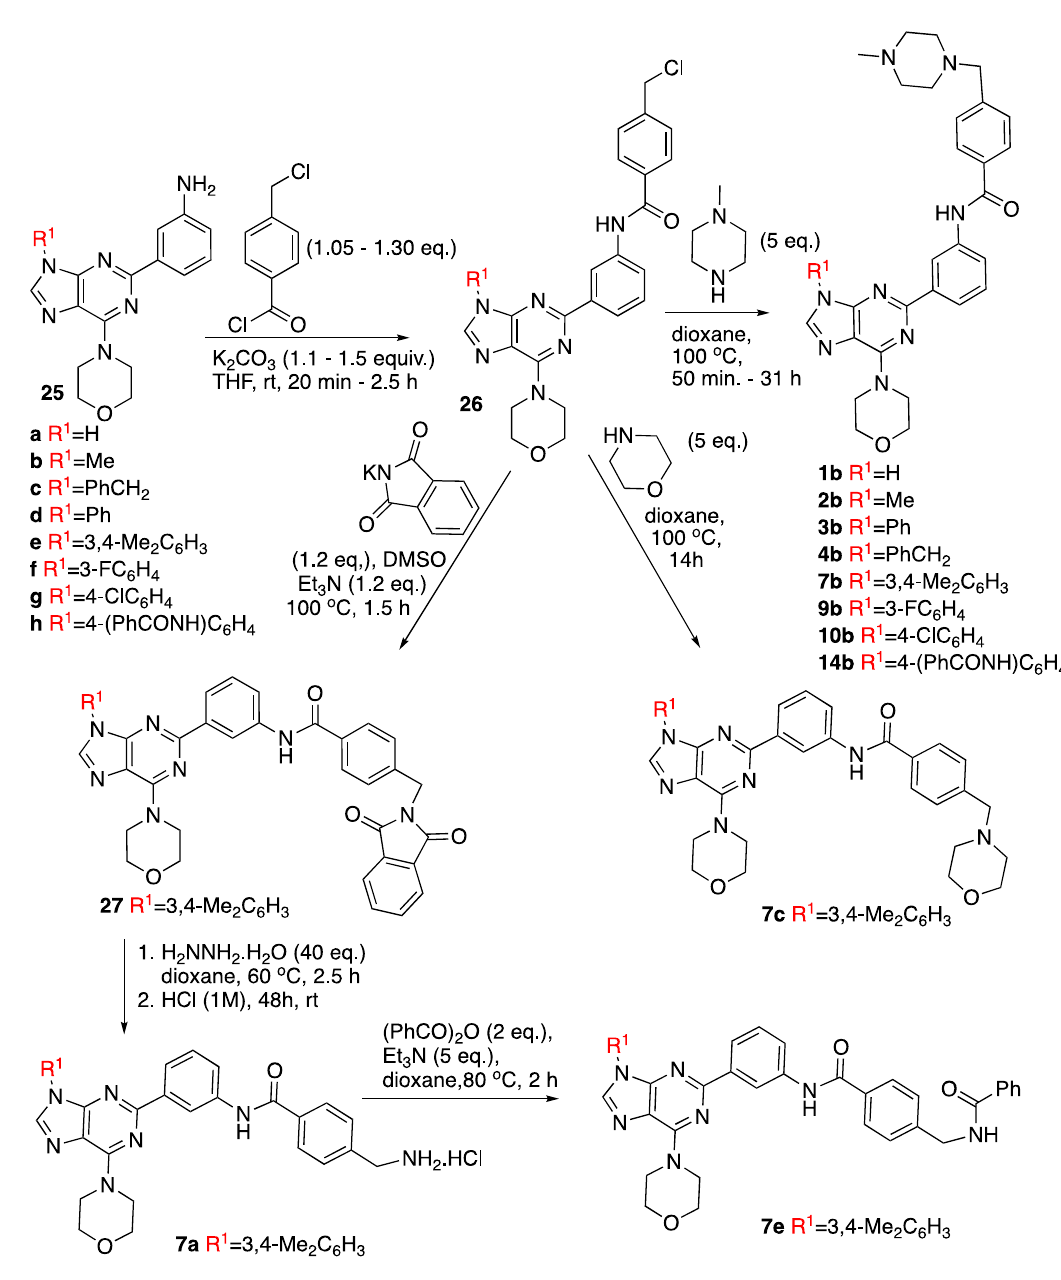
Scheme 2. Synthesis description of compounds 26 and the PI3K